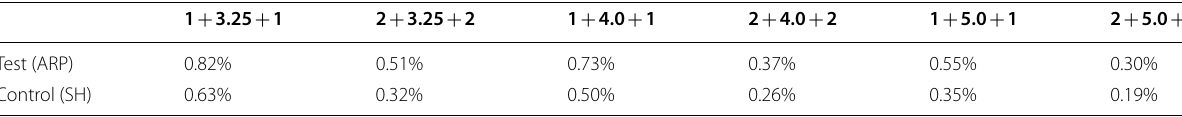
Table 4 Overview of the probabilities to place a standard diameter implant in relation to a predefined bony housing